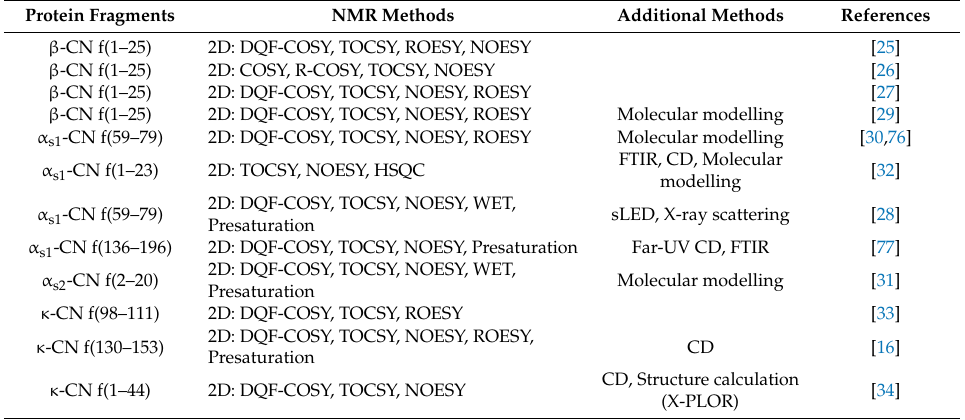
Table 2. NMR structural studies on peptides from caseins ( β -, α s 1 -, α s 2 -, κ -casein) including the performed NMR methods and additional methods used. Abbreviations: WET - water suppression enhanced through T1 e ff ect; sLED - suppression longitudinal encode decode. For other abbreviations see Table